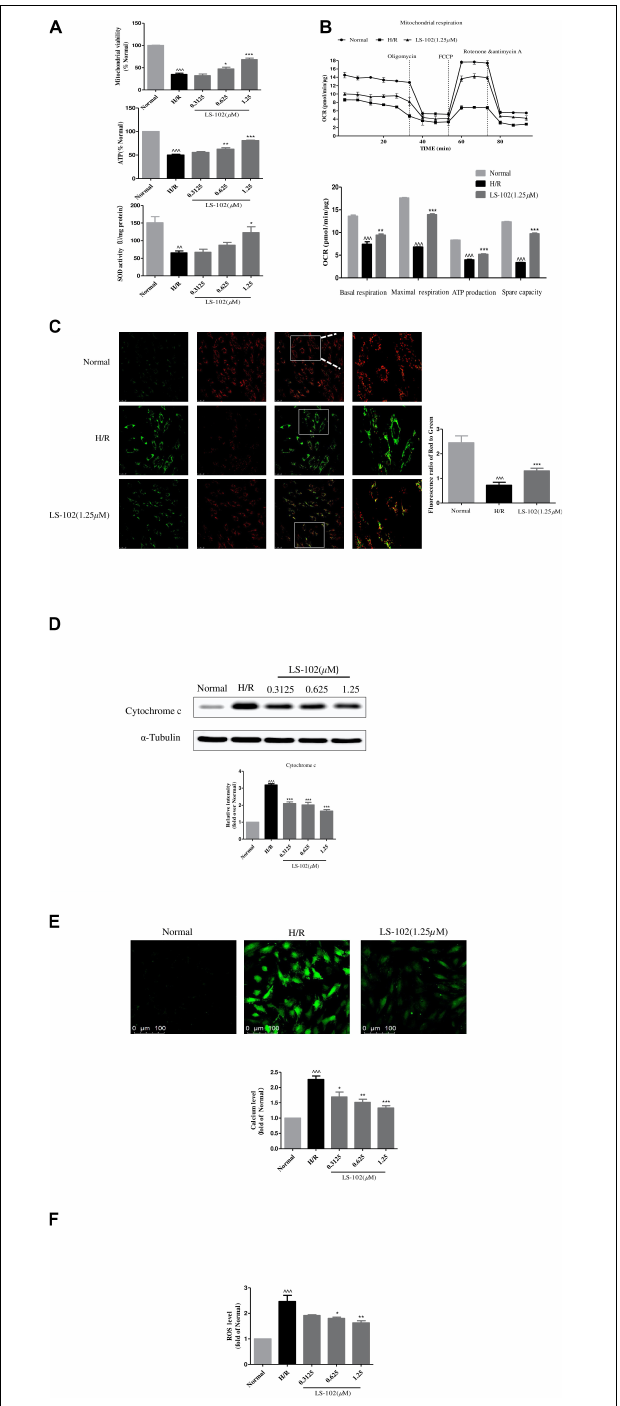
FIGURE 5 | Effects of LS-102 on the mitochondrial dysfunction induced by H/R in H9c2 cells. (A) Effect of LS-102 on mitochondrial viability, the content of ATP, and SOD activity. (B) The Seahorse XFp Extracellular Flux Analyzer was used to evaluate the effect of LS-102 on oxygen consumption rate (OCR). (C) Representative images of JC-1 fluorescent dye stained the mitochondrial membrane potential captured by confocal microscopy with × 40 objective (Olympus). Using the fluorescence microplate assay to calculate the